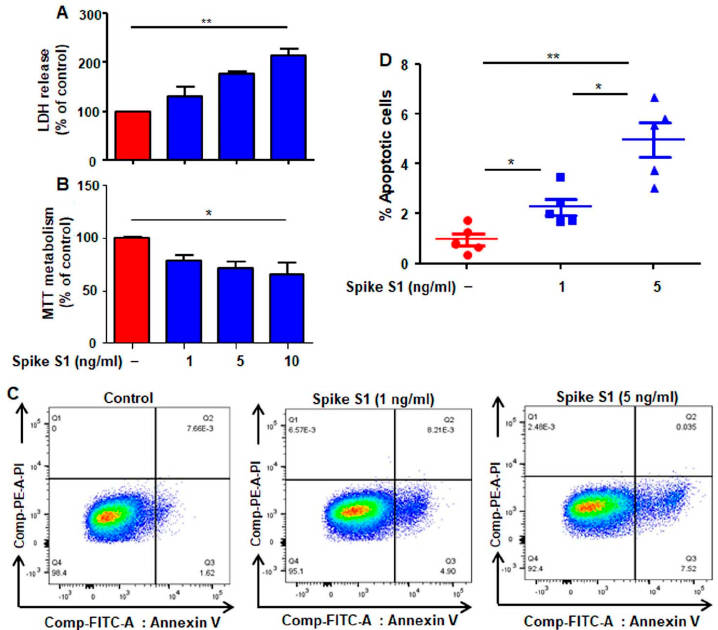
Figure 2. Effect of recombinant SARS-CoV-2 spike S1 on the survival of human A549 lung cancer cells. A549 cells were treated with different concentrations (1, 5, and 10 ng/mL) of recombinant spike S1 protein for 24 h under serum-free condition followed by monitoring cell death by LDH release ( A ) and MTT ( B ). FACS double staining with annexin V and propidium iodide (PI) was also performed ( C ). Quantitative analysis of percent apoptotic cells is presented ( D ). Values are presented as mean ± SD of three independent experiments. * p < 0.05; ** p < 0.01. To confirm the apoptosis further, we performed TUNEL staining and found increase in TUNEL-positive cells by spike S1 treatment (Figure 3A).